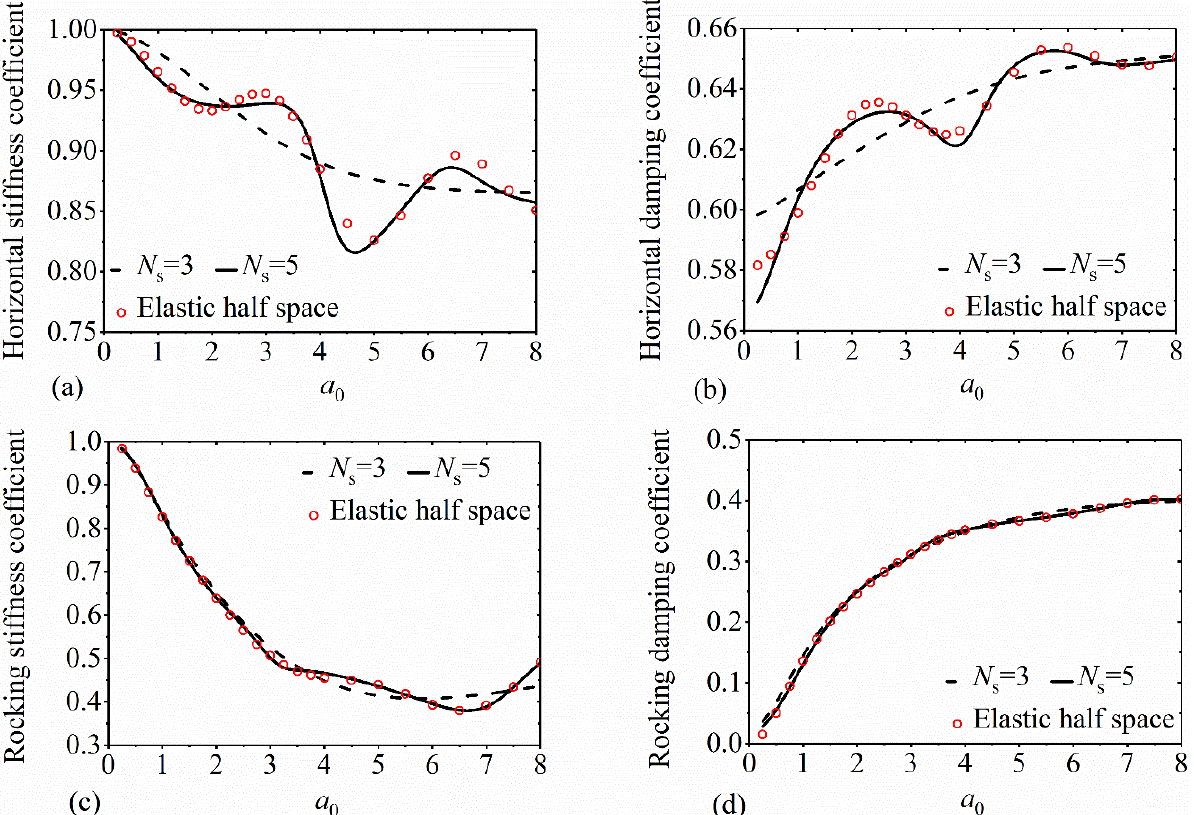
Figure 6. Impedance of the circular surface foundation for varying dimensionless frequencies a 0 in comparison with the elastic half space results [28]: ( a ) horizontal stiffness coefficient; ( b ) horizontal damping coefficient; ( c ) rocking stiffness coefficient; ( d ) rocking damping coefficient. Table 1. The coefficients for the springs and dashpots for the nested LPMs with the degree N s = 5. Coefficient